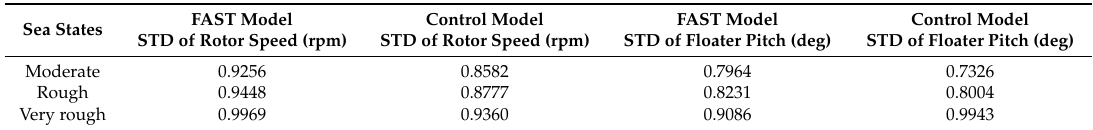
Table 2. Verification of the FOWT model for control